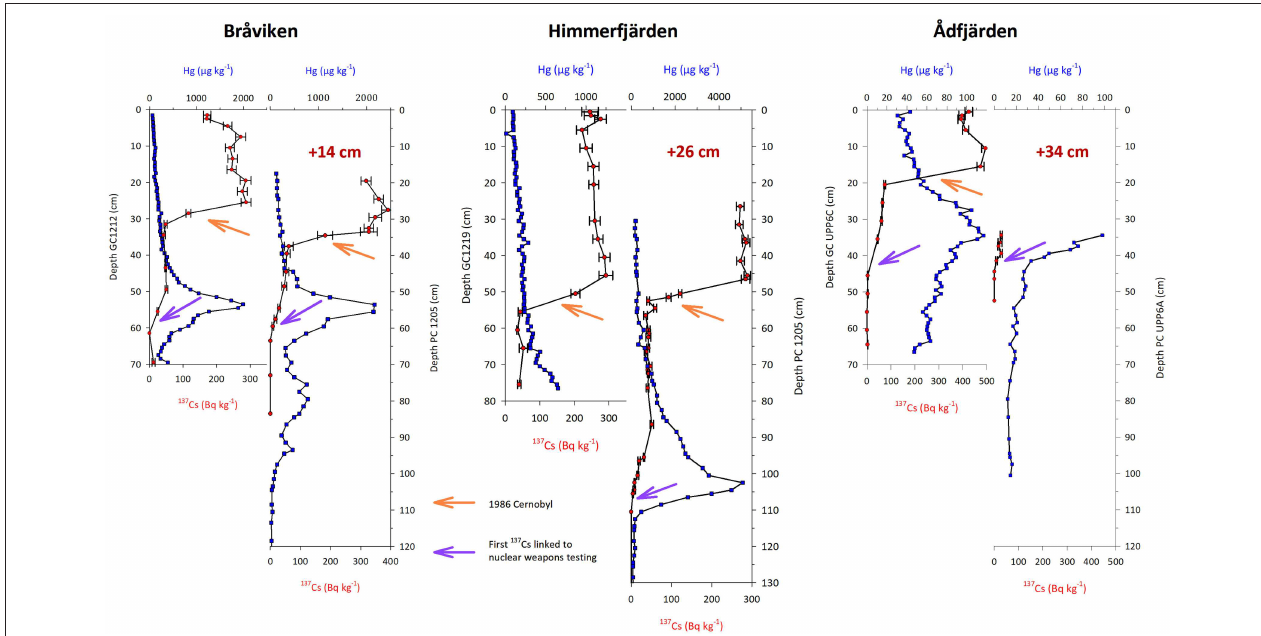
FIGURE 2 | Correlation between the short gravity cores (GC) and the long piston cores (PC) from the sites Bråviken, Himmerfjärden, and Ådfjärden. Marker levels used as fixpoint for the correlations, 137 Cs increase linked to the nuclear weapons testing at c. 1960 and the 1986 Cernobyl accident, indicated by purple and orange arrows, respectively. Offset between the gravity cores and the piston cores indicated in red